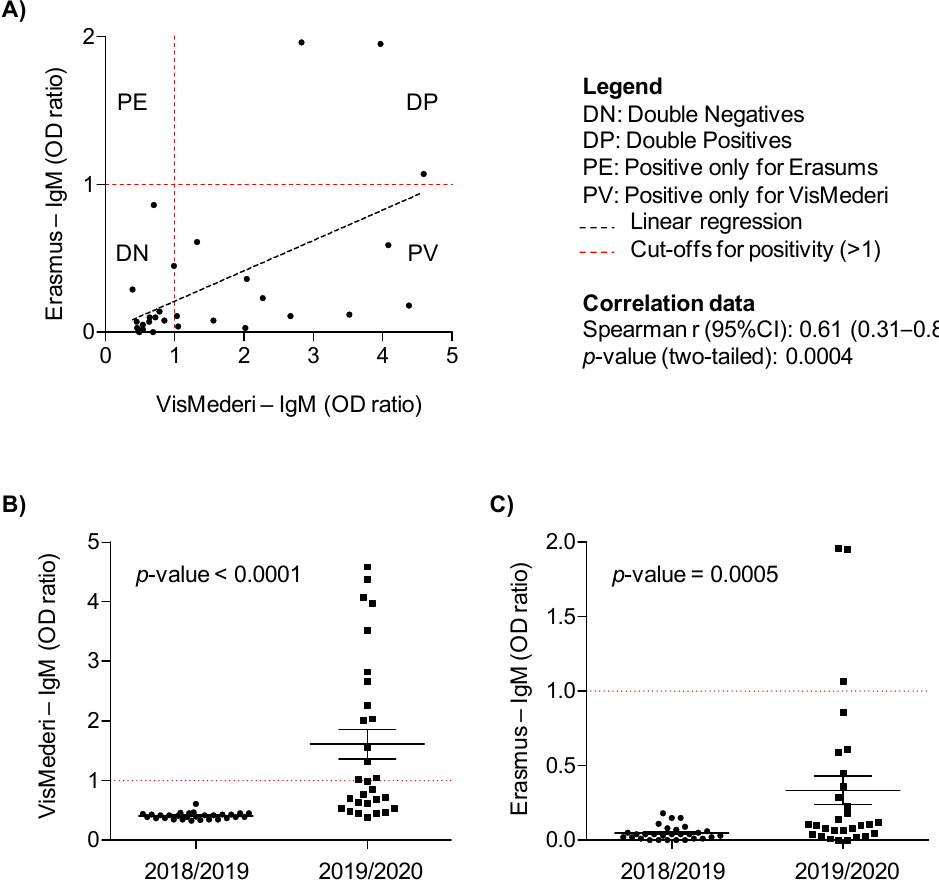
Figure 1. Comparison of IgM data between VisMederi and Erasmus. ( A ) The scatter plot shows the correlation between IgM values (OD ratios) obtained in the two laboratories, considering the 29 selected samples collected from asymptomatic subjects enrolled in the SMILE lung cancer screening trial between July 2019 and February 2020. The dot plots show the distribution of IgM values (OD ratio) obtained by ( B ) VisMederi and ( C ) Erasmus in 29 samples of the SMILE screening trial enrolled in 2019/2020 and 29 matched lung cancer screening volunteers enrolled in the same months of 2018/2019. Horizontal black bars indicate mean value ± standard error. Mann–Whitney p -values are reported.